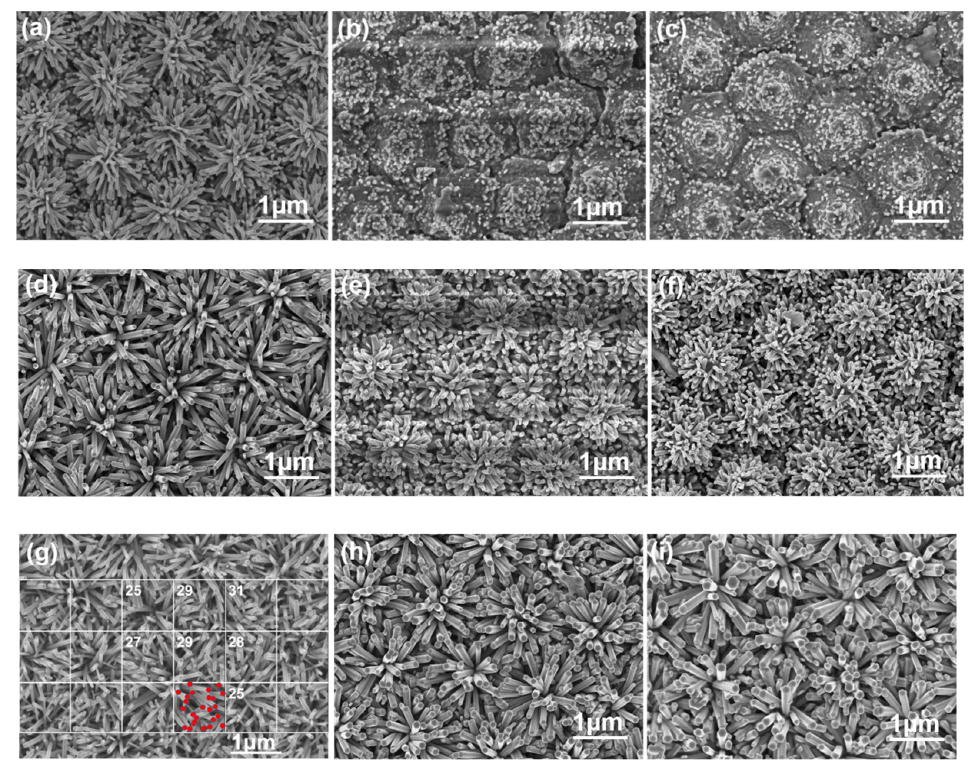
Figure 6. SEM images of the surface of the ZnO nanoflower arrays with a synthesis time of 10 min on Al sacrificial layers of different thicknesses: ( a ) 120, ( b ) 420, and ( c ) 720 nm. With a synthesis time of 30 min on Al sacrificial layers of different thicknesses: ( d ) 120, ( e ) 420, and ( f ) 720 nm. With a synthesis time of 60 min on Al sacrificial layers of different thicknesses: ( g ) 120, ( h ) 420, and ( i ) 720 nm.